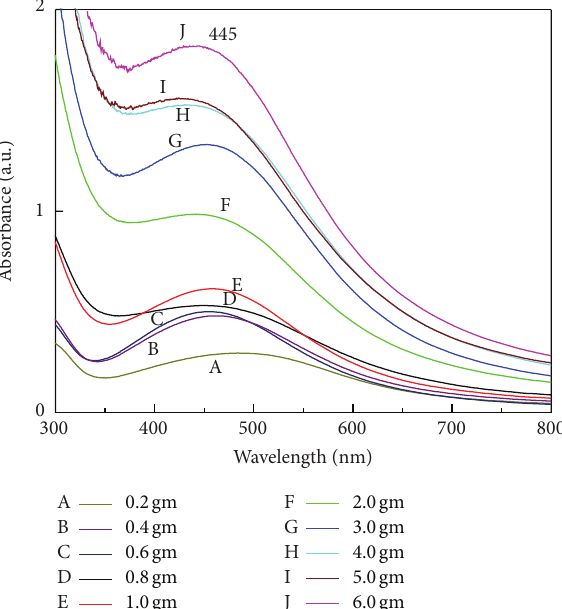
Figure 9: Effect of quantity of biomass (g/100mL) on synthesis of SNPs. UV-Vis extinction spectra show increase in absorbance with increase in biomass quantity. Quantity of biomass is proportional to synthesis of